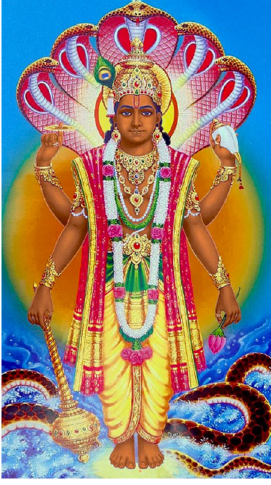
Figure 1. In this image we can see the characteristic depiction of Vis.n.u with his activities that do not constrain him, such as the disk and mace. We also see him holding the conch, the symbol of objectivity (what we can perceive from various vantages and what appears different according to vantage), as well as Laks.m¯ı, who is also Padma, the Lotus. In being distinct from these activities, Vis.n.u shows himself to be tapas: unconservative, self-challenging, activity, which is at once responsible for, but not constrained by, one’s own activity. ¯Adi ´Ses.a, the cosmic snake, also ¯I´svara Pran.idh¯ana (devotion to Sovereignty), is seen with him. Reprinted with permission from Bajirao 1007 from Wiki and licensed under the attribution and share alike license